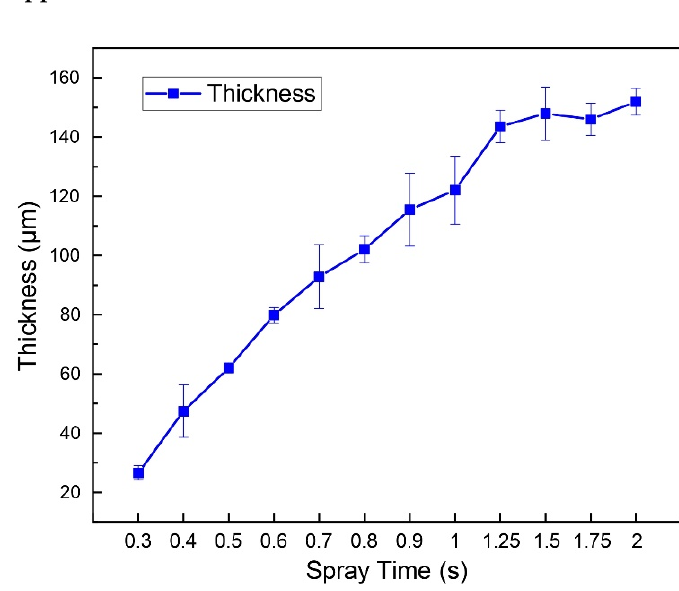
Figure A1. Film thickness of LM with different spray times.